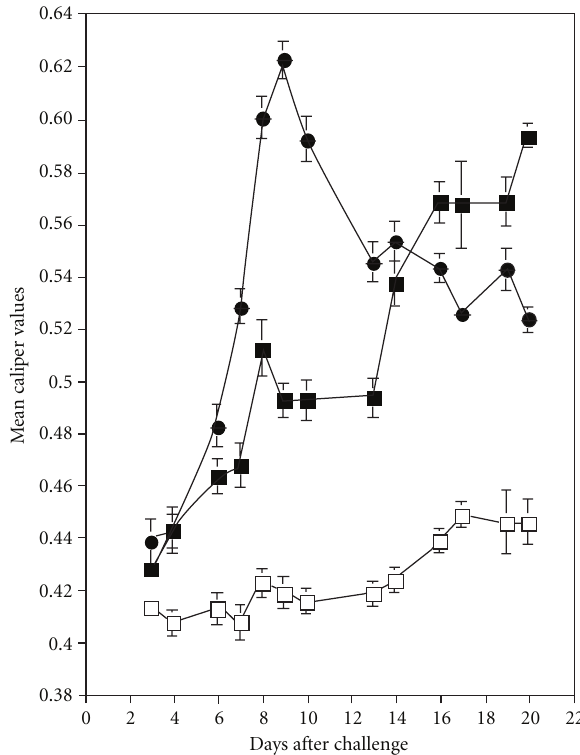
Figure 1: Swelling of the tibiotarsal joint detected in irradiated C3H/HeJ mice injected with B. burgdorferi sensu stricto isolate 297 ( (cid:2) ) or BSK medium ( (cid:3) ) and in nonirradiated C3H/HeJ mice infused with B. burgdorferi 297 ( •